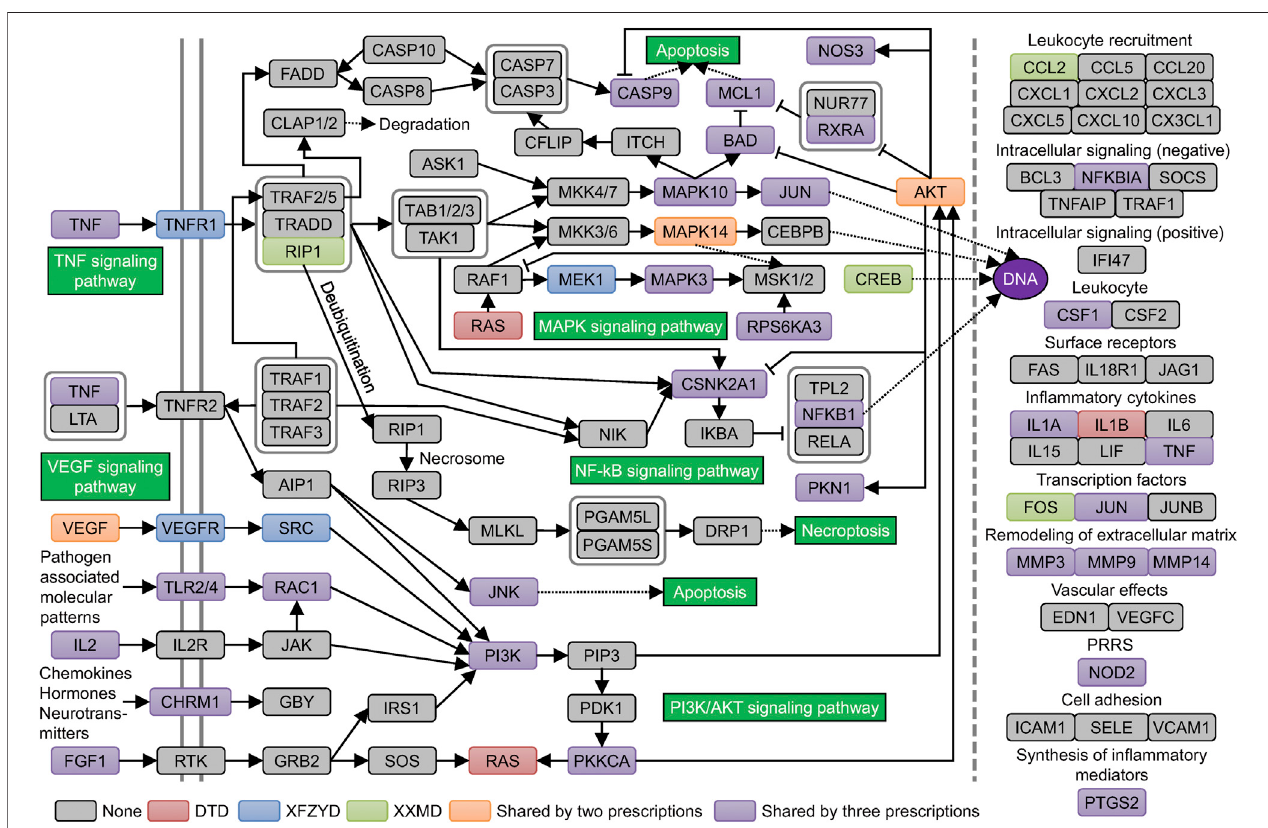
FIGURE 5 | Curated KEGG pathways related to the pathogenesis of stroke: Curated pathways are shown in the green boxes. Genes are shown in colored, rounded rectangles.